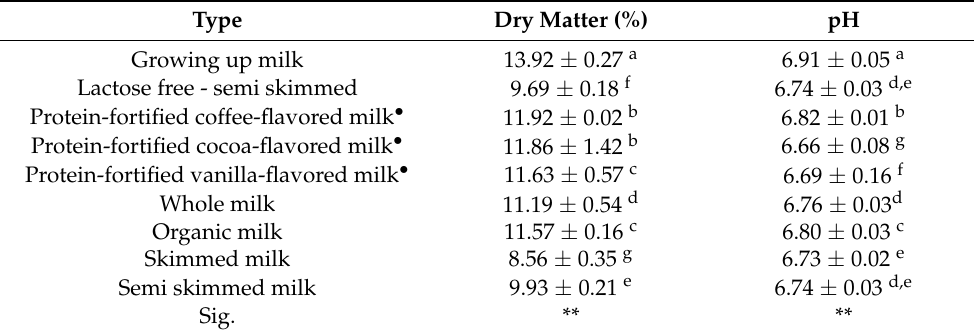
Table 2. The dry matter contents (%) and pH values of milk samples (mean ± SD).